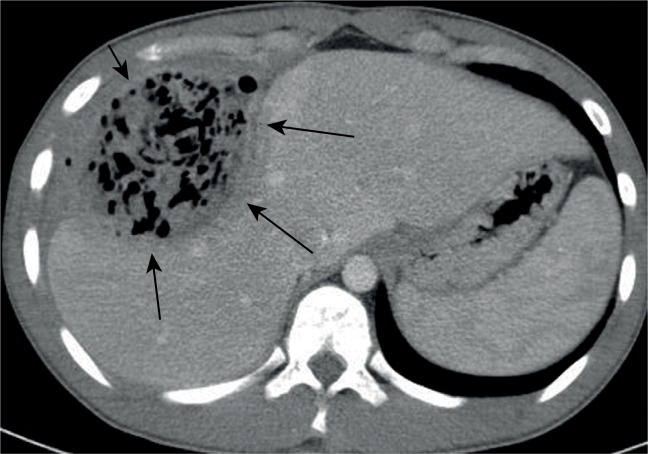
TC de tórax com janela para o mediastino, sem contraste intravenoso.
Presença de massa ovalada no terço inferior do hemitórax direito, com
densidade de partes moles, contendo imagem linear densa que corresponde
ao marcador (setas) da compressa retida. A lesão tem contorno regular e
mantém, em sua maior extensão, íntimo contato com a superfície
pleural.